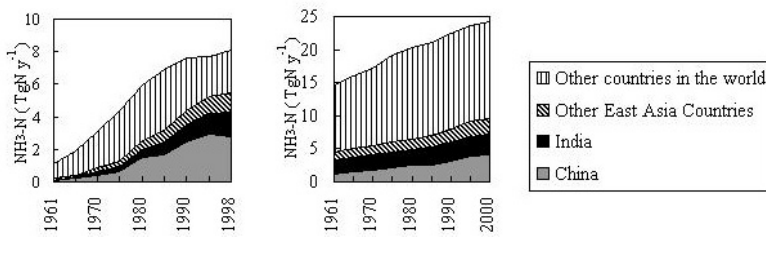
FIGURE 6. Yearly changes in NH